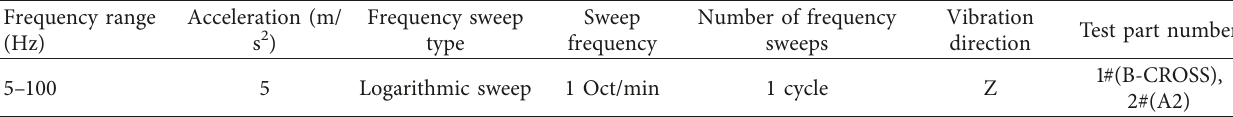
Figure 25: Fatigue analysis solution results. (a) Cloud image of fatigue damage of front frame; and (b) cloud diagram of front-end frame fatigue life. Table 7: Resonance check vibration experimental conditions.